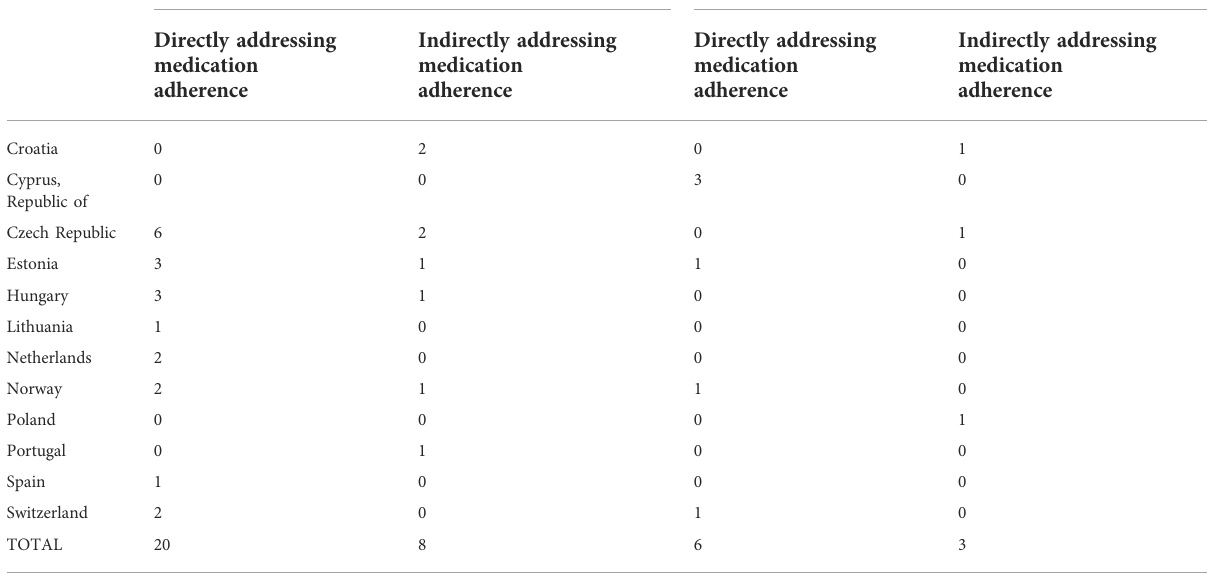
TABLE 2 Statistics of reimbursed MAEIs identi fi ed across 12 European countries. Country Currently employed interventions, N Interventions planned in the future,